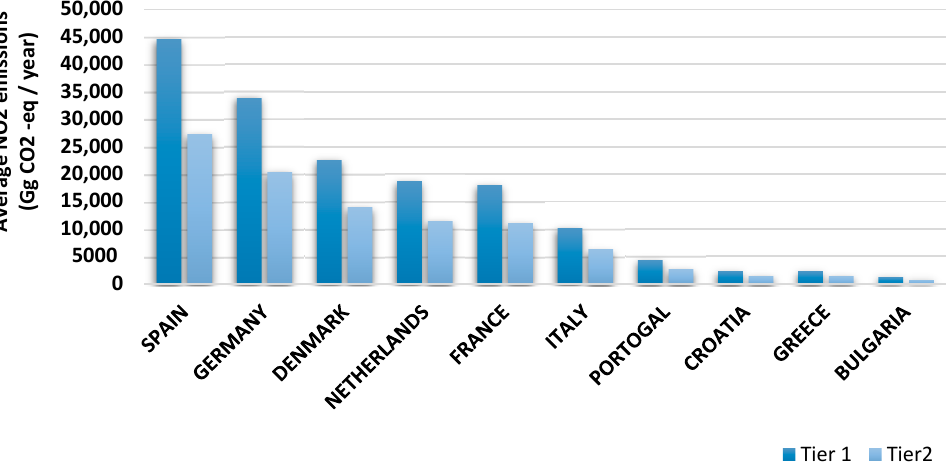
Figure 2. Comparison of mean N 2 O emissions (Gg CO 2 -eq) from manure management using Tier 1 and 2 methodologies.